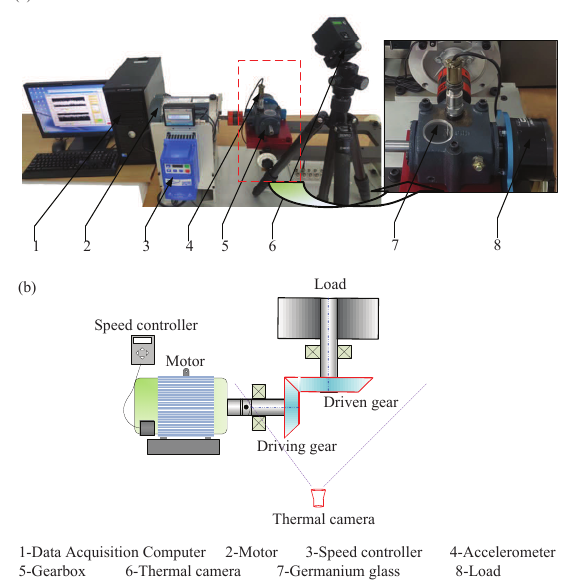
Figure 4. ( a ) The machinery fault simulator system, ( b ) the schematic diagram of the test rig and thermal camera